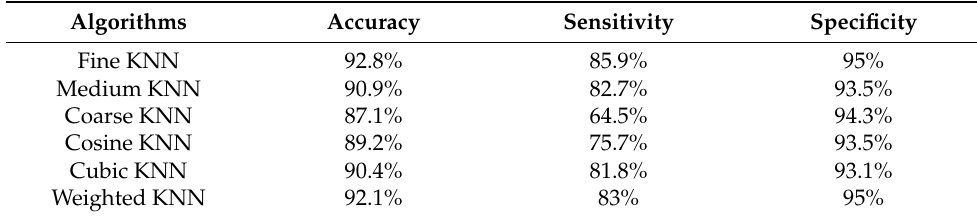
Table A6. Detailed classification performance of k-nearest neighbor (KNN) classifiers.